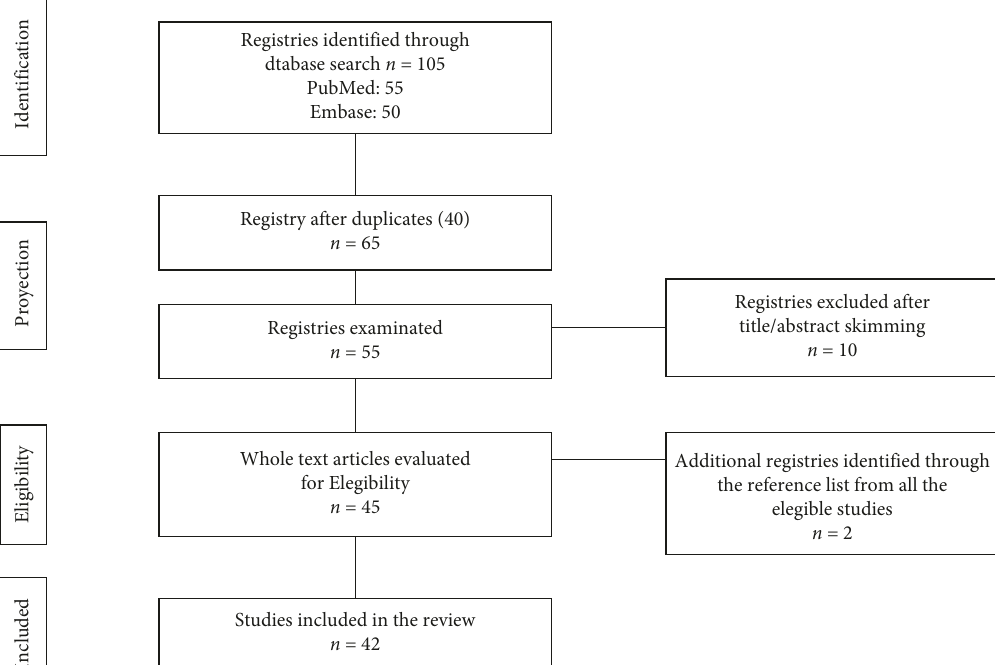
Figure 1: Flowchart describing the cases selection process.